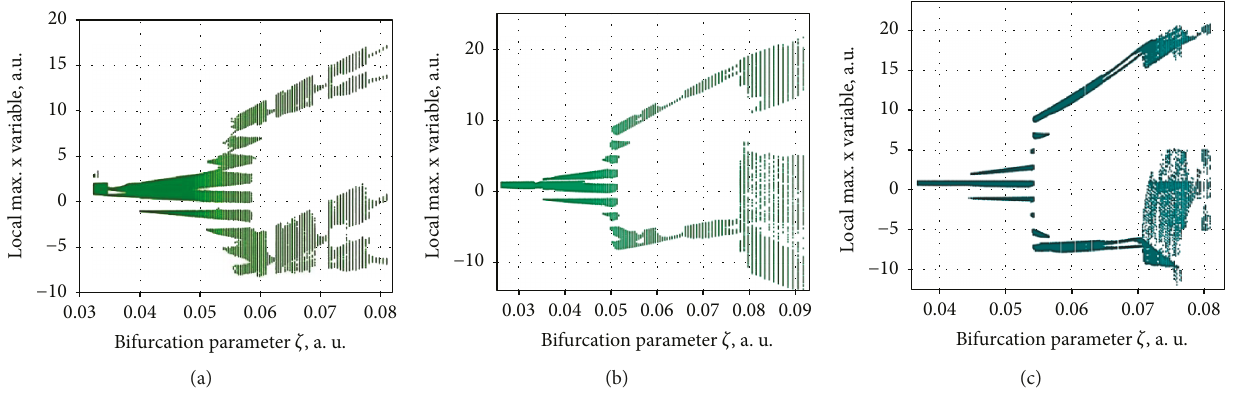
Figure 3: Bifurcation diagram for the dynamical control parameter (a) α = 0 45 , (b) α = 0 70 , (c) α = 0 90